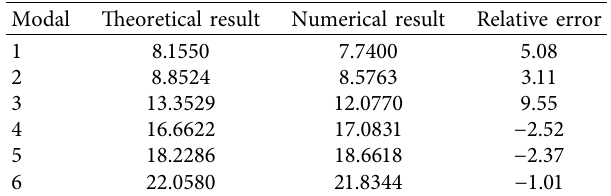
Figure 5: Finite element model of the microvibration suppression device. Table 4: Comparison of nature frequencies solved by analytical and numerical